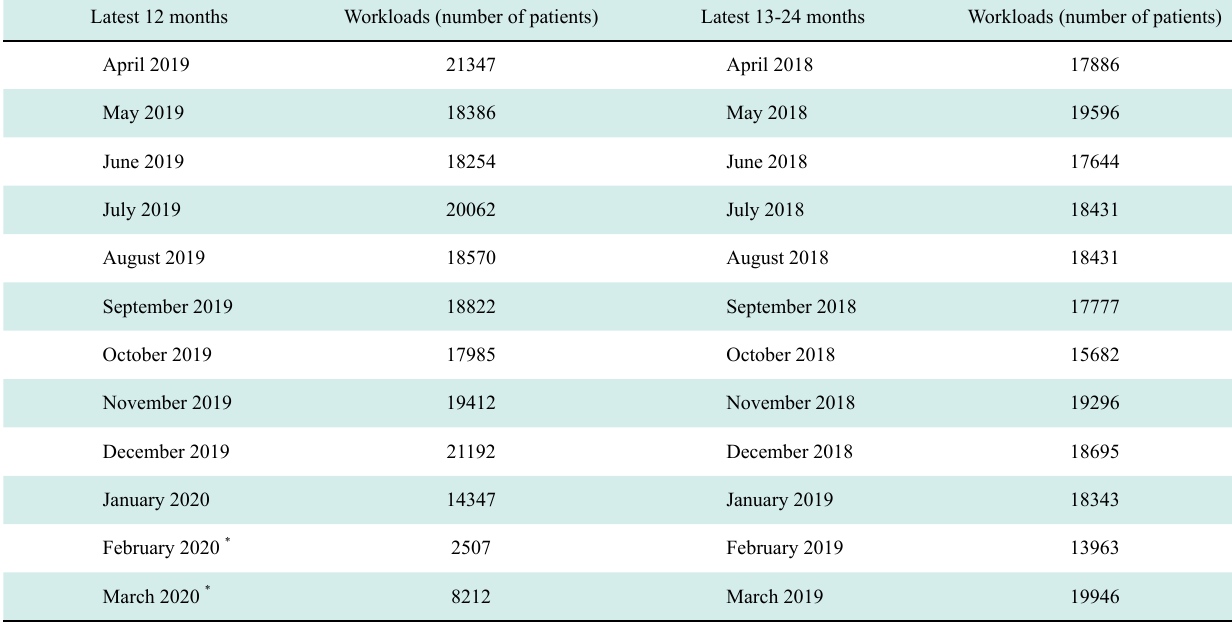
Table 1 Workloads of ultrasound outpatient area in the past 24